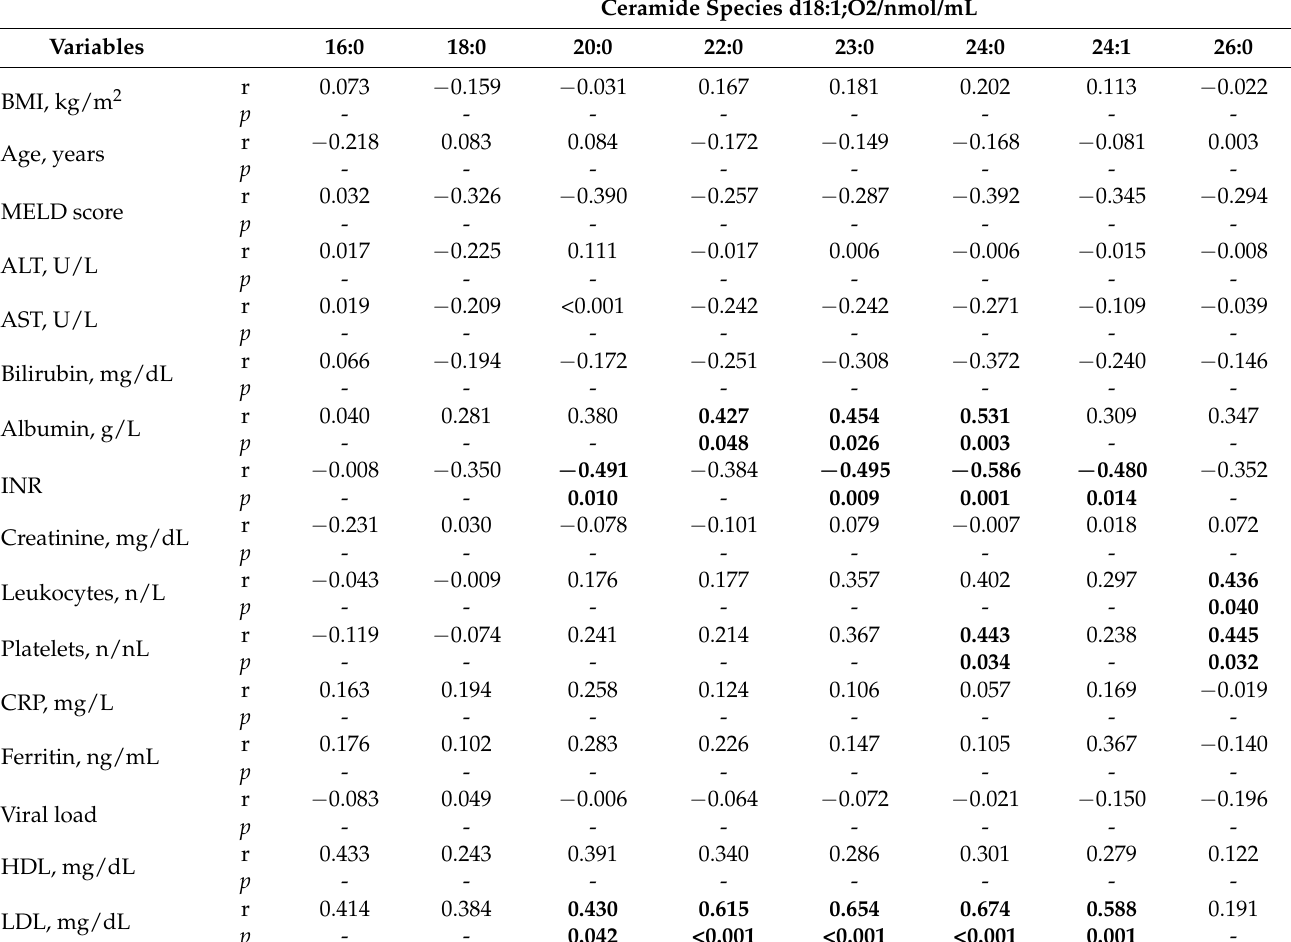
Table 4. Spearman correlation coefficients and p -values for the correlations of ceramide species with BMI, age, MELD score, viral load, and routine laboratory parameters in the 40 HCV patients with liver cirrhosis before direct-acting antiviral (DAA) therapy. Significant correlations are in bold (alanine amino transferase (ALT), aspartate aminotransferase (AST), body mass index (BMI), C-reactive protein (CRP), high-density lipoprotein (HDL), international normalized ratio (INR), low-density lipoprotein (LDL), model of end-stage liver disease (MELD), not significant